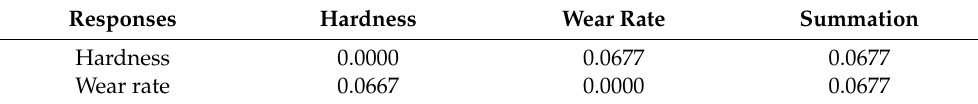
Table 7. Determining the summation of different responses.